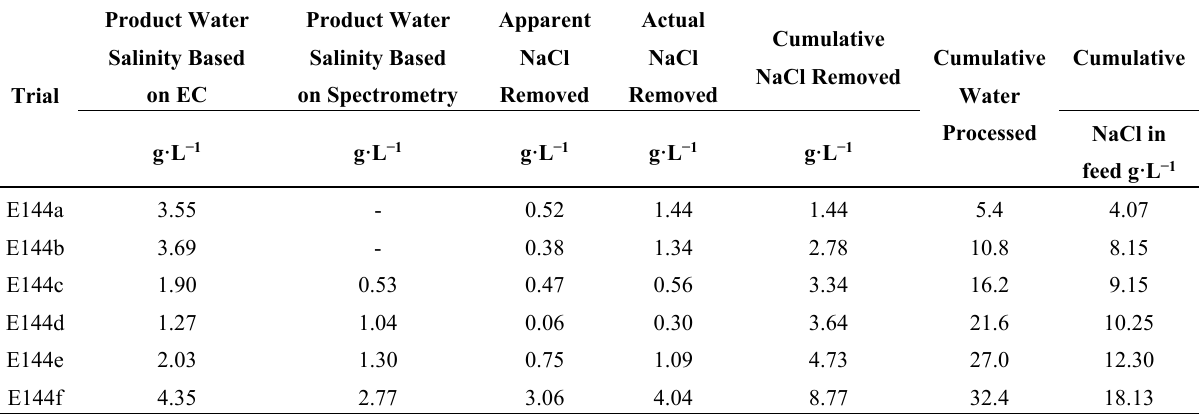
Table C13. ZVM TPA Example (Trial E146): Feed Water and Product Water